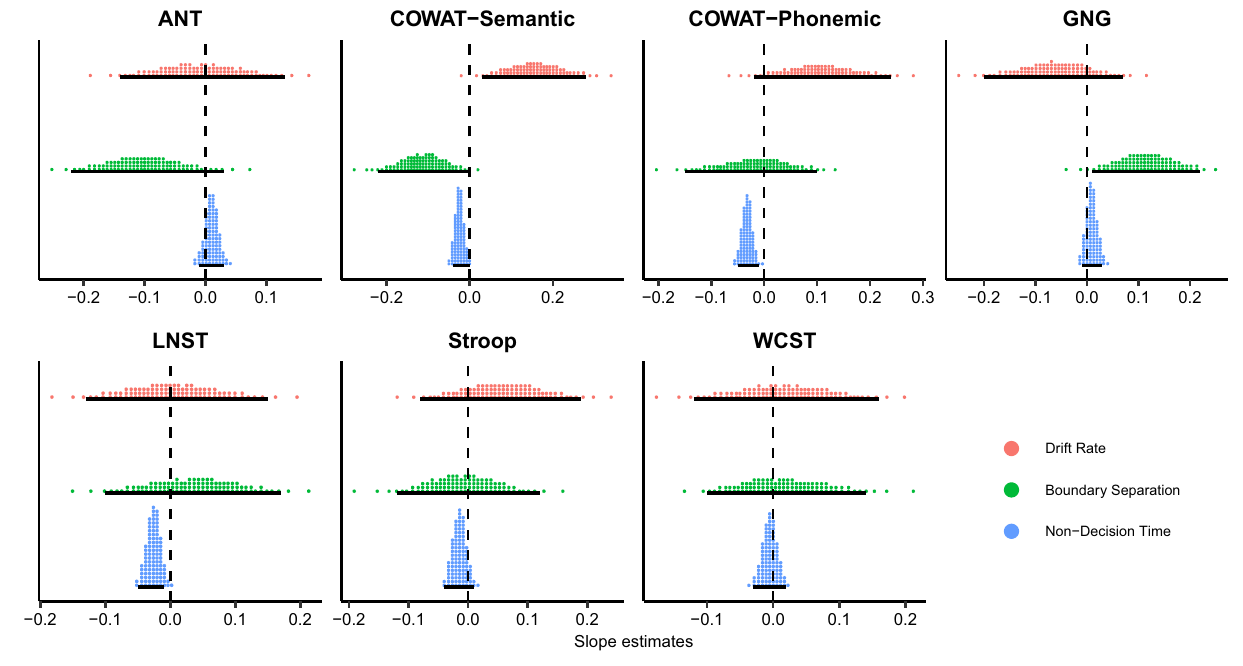
Figure 5. Population-level slope estimates of decision parameters with respect to seven neuropsychological test performances. To illustrate the relationship between participants’ performances in each test and the decision parameters, population-level slope estimates of drift rates, boundary separation, non-decision time are described as quantile dotplots. As 95% HDI of a certain parameter’s estimates (illustrated as black bars) moves away from zero, individuals’ performances in the neuropsychological test are positively or negatively correlated with the decision parameters. The scores in ANT, Stroop task, and WCST were transformed to indicate that higher scores represent better performance. ANT attention network test, COWAT controlled oral word association test, GNG go/no-go, LNST letter number sequencing task, WCST Wisconsin card sorting test, HDI highest density